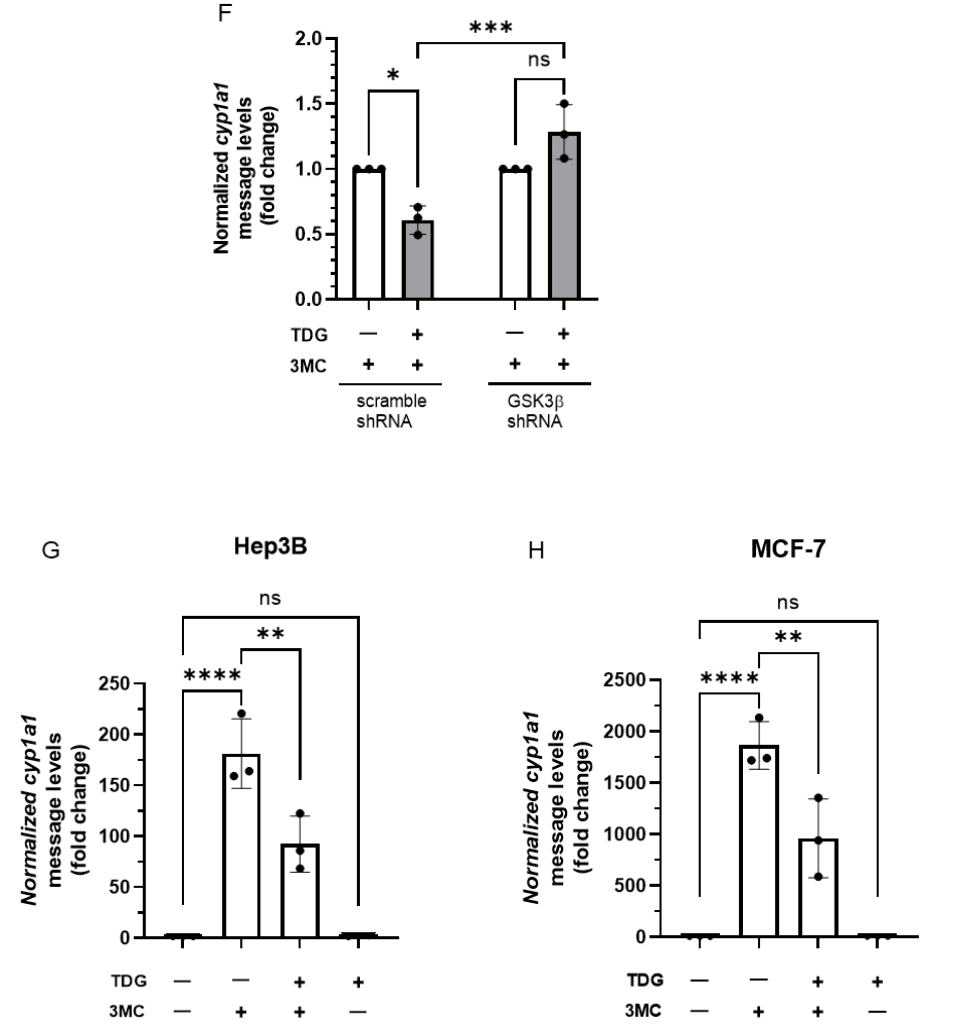
Figure 8. Reduction of GSK3 β activity suppresses the ligand-dependent activation of AHR target gene transcription. For A and B, HeLa cells were treated with 40 µ M TDG for 9 h. At 5-h post-TDG treatment, cells were treated with either ( A ) 10 µ M β NF, 10 µ M CH223191 or both or ( B ) 1 µ M 3MC, 10 µ M CH223191 or both. TDG were able to partially block the increase of the cyp1a1 message levels triggered by β NF and 3MC. Co-treatment of TDG with CH223191 further decreased the cyp1a1 message levels. For A and B, the graphs represent replicate data (means ± SD, n = 3 except that n = 4 for DMSO, TDG + 3MC and TDG + 3MC + CH223191 groups in 8B, * p < 0.05, *** p < 0.001, **** p < 0.0001) and DMSO group was arbitrarily set as one (with no error bar) for data normalization. HeLa cells were transiently transfected for 70 h with the plasmid carrying scramble shRNA or GSK3 β specific shRNA. Cells were then treated with ( C ) DMSO or 10 µ M β NF, ( D ) DMSO or 5 µ M BaP, ( E ) DMSO or 1 µ M 3MC for 4 h. Cells were harvested at 74-h post transfection/4-h post ligand treatment. The increase level of the cyp1a1 message after ligands treatment were significantly lower in GSK3 β knockdown groups. For C to E, graphs represent replicate data (means ± SD, n = 3, * p < 0.05, ** p < 0.01, *** p < 0.001, **** p < 0.0001) with DMSO group arbitrarily set as one (with no error bar) for data normalization. ( F ) 7.5-h treatment of TDG (40 µ M, treated at 70–77.5 h post-transfection) could not suppress the 3MC (1 µ M, 3.5 h, treated at 74-77.5 h post-transfection) induced cyp1a1 messages in GSK3 β shRNA transfected HeLa cells as observed in scramble shRNA transfected HeLa cells. The graph represents the replicate data (means ± SD, n = 3, * p < 0.05, *** p < 0.001, ns represents not significant) with 3MC groups minus TDG were arbitrarily set as one (with no error bar) for data normalization. Hep3B ( G ) and MCF-7 ( H ) cells were treated 40 µ M TDG for 9 h. At 5-h post-TDG treatment, cells were treated with 1 µ M 3MC for 4 h. The induced cyp1a1 message levels were suppressed by TDG in both cell lines. The graphs in G and H represent replicate data (means ± SD, n = 3, ** p < 0.01, **** p < 0.0001, ns represents not significant) with DMSO group arbitrarily set as one (with no error bar) for data normalization. For A to H, one-way ANOVA with Sidak multiple comparisons test was performed to determine statistical